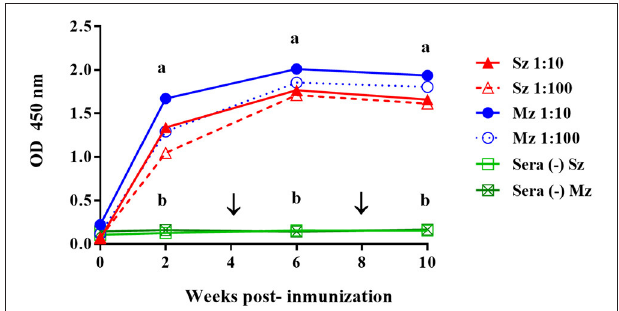
FIGURE 1 | Comparison of the time course of the antibody response to sporozoite (Sz) and merozoite (Mz) antigens in pullets immunized with E. tenella by gavage. Sera dilutions of 1:10 (continuous line) and 1:100 (dotted line) are shown. The arrows indicate the boost immunizations at intervals of 4 weeks. Sera from unimmunized pullets (–) did not show any reactivity with the Sz and Mz antigens. At each time point, the arithmetic means ± standard deviations of the absorbance units (O.D.) of sera collected from six birds are shown. The line plots denoted as a are significantly different ( P < 0.05, according to Tukey’s multiple range test) from those denoted as